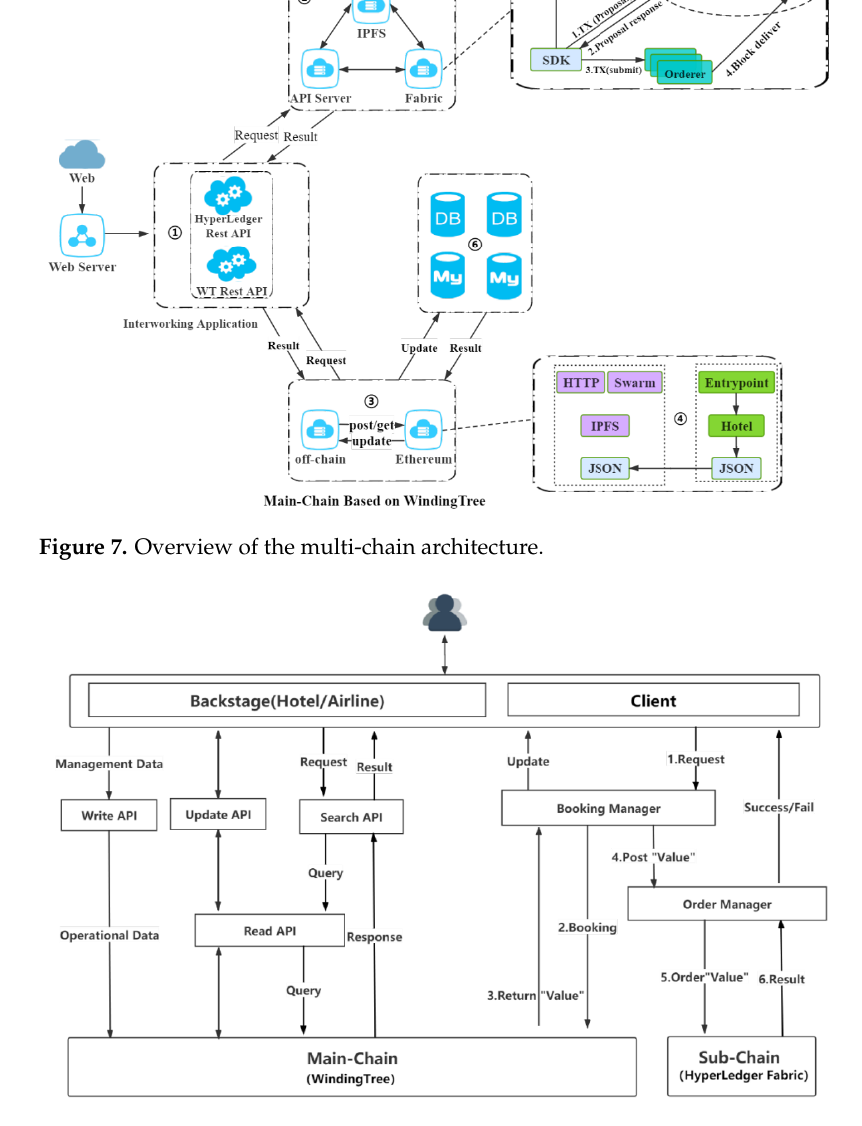
Figure 8. Interworking process based on multi-chain for secure tourism service.